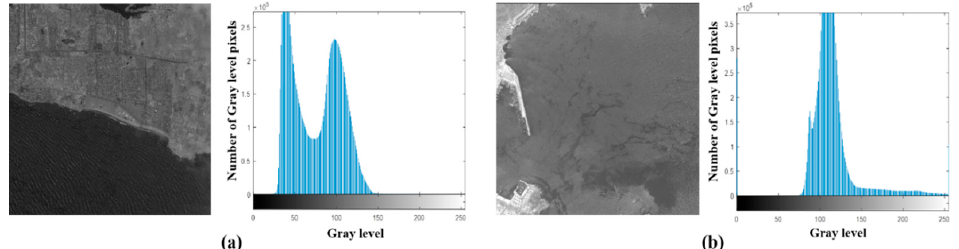
Figure 1. Gray level histograms of original optical panchromatic remote sensing images: ( a ) water-land scene with separable water body gray level histogram; ( b ) water-land scene with non-separable water body gray level histogram.